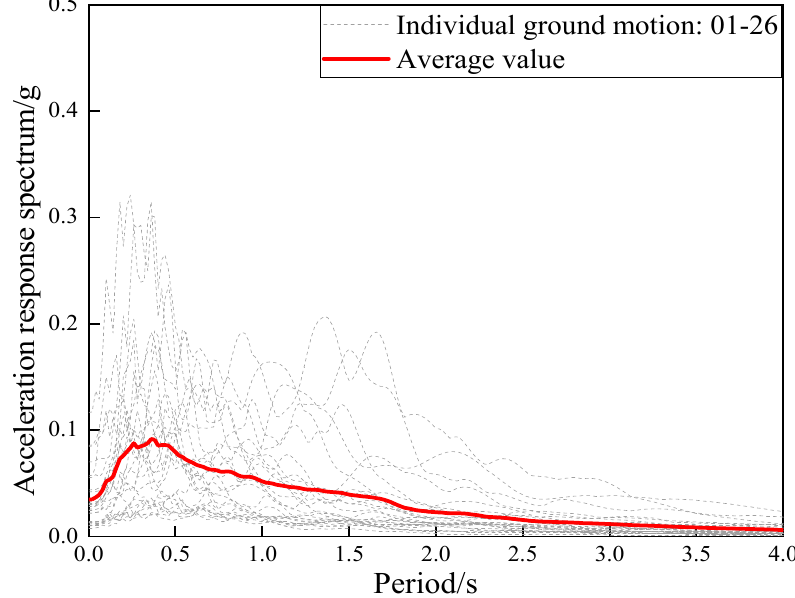
Figure 5. Aftershock response spectrum curves.